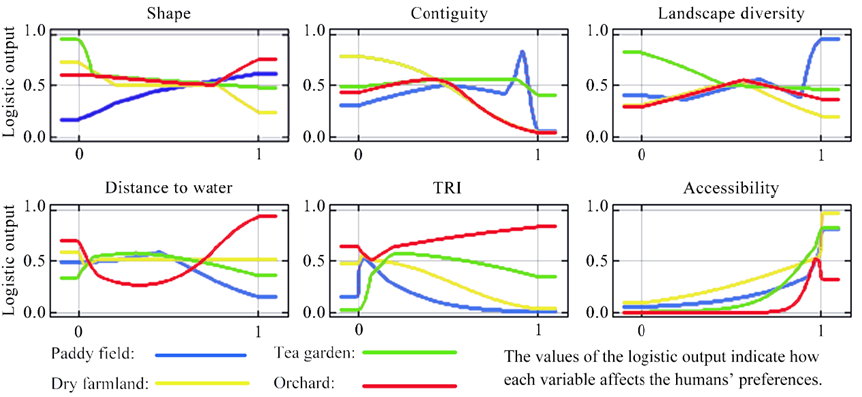
Figure 7. Response curves, produced by the Maxent model, of each environmental indicator affecting CES flow patterns.